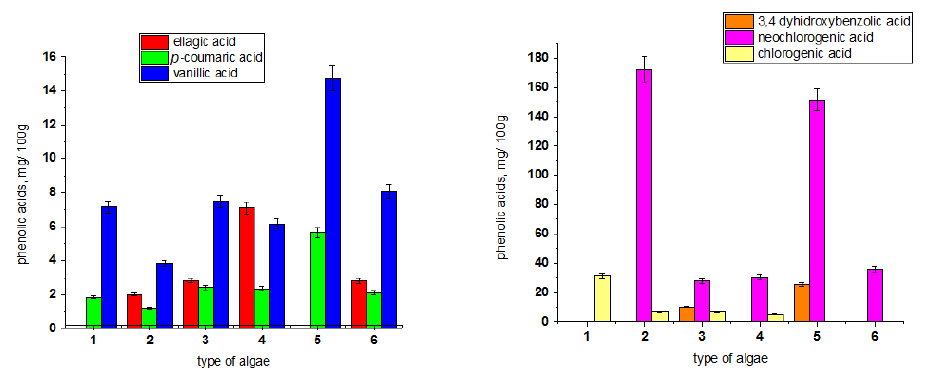
Figure 4. The phenolic acids content of algae (mg/100 g) determined by HPLC. 1. A. platensis (con- vection dried); 2. A. platensis (lyophilized); 3. U. intestinalis; 4. C. linum ; 5. E. crinita ; 6. Chlorella spp.